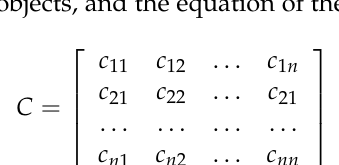
Figure 9. The SA dataset. ( a ) False-color image, ( b ) Ground-truth image, ( c )